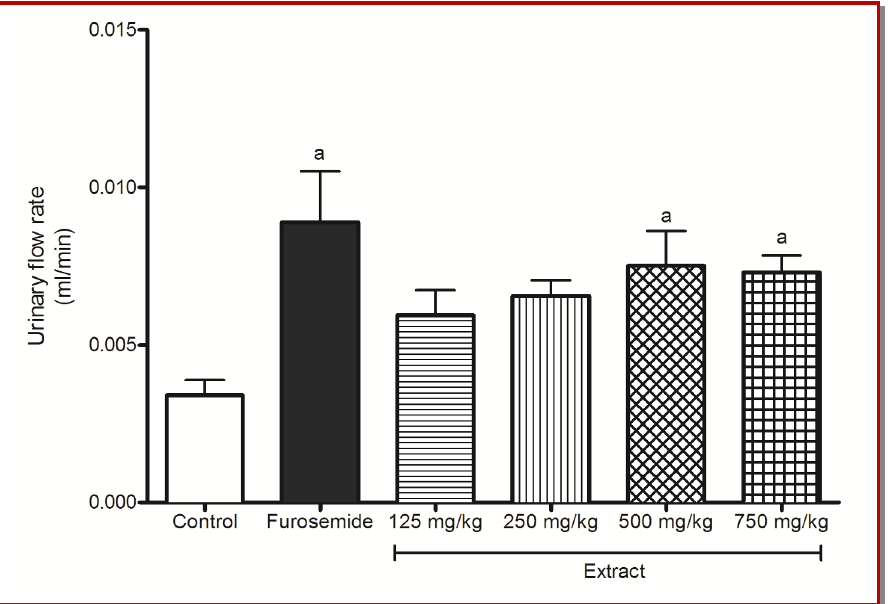
Figure 1: Effect of aqueous extract of E. polystachya on urinary flow rate in rats. Mean ± SEM of six animals per group; a p<0.05 compared with control